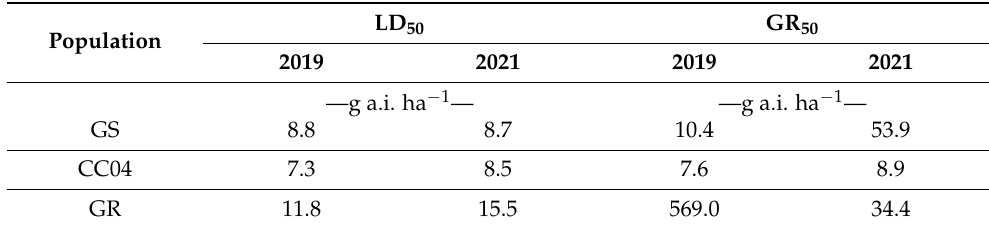
Table 6. Propaquizafop dose required to kill 50% of plants (LD 50 ) or cause a 50% reduction in growth (GR 50 ).